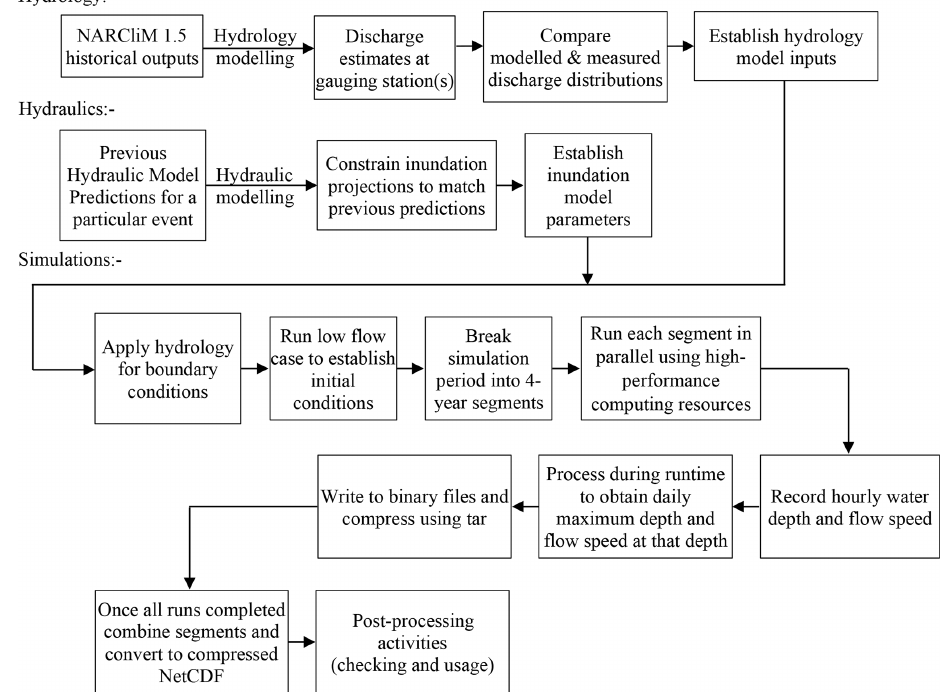
Figure 1. Proposed framework for converting climate model outputs to flood model outputs.